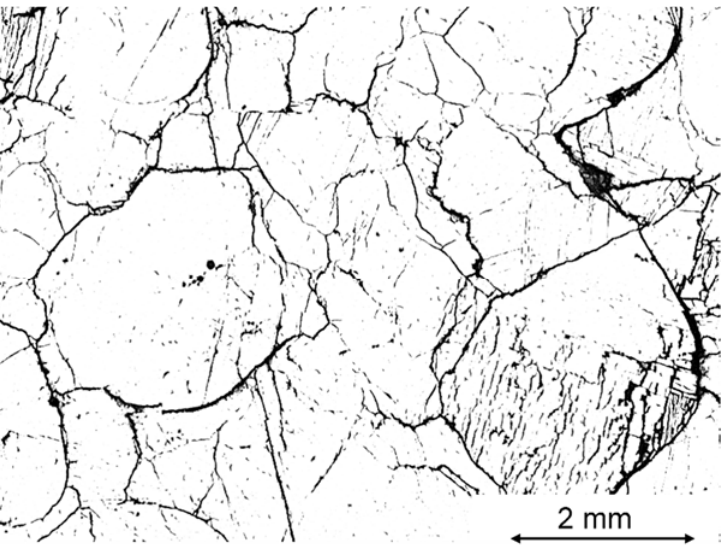
Figure 3. Example of a probability map of sample 74 (TD = 4% TD; heated to 500°C) in which the black pixels are predicted to be fractures and the white pixels are predicted to be grains.